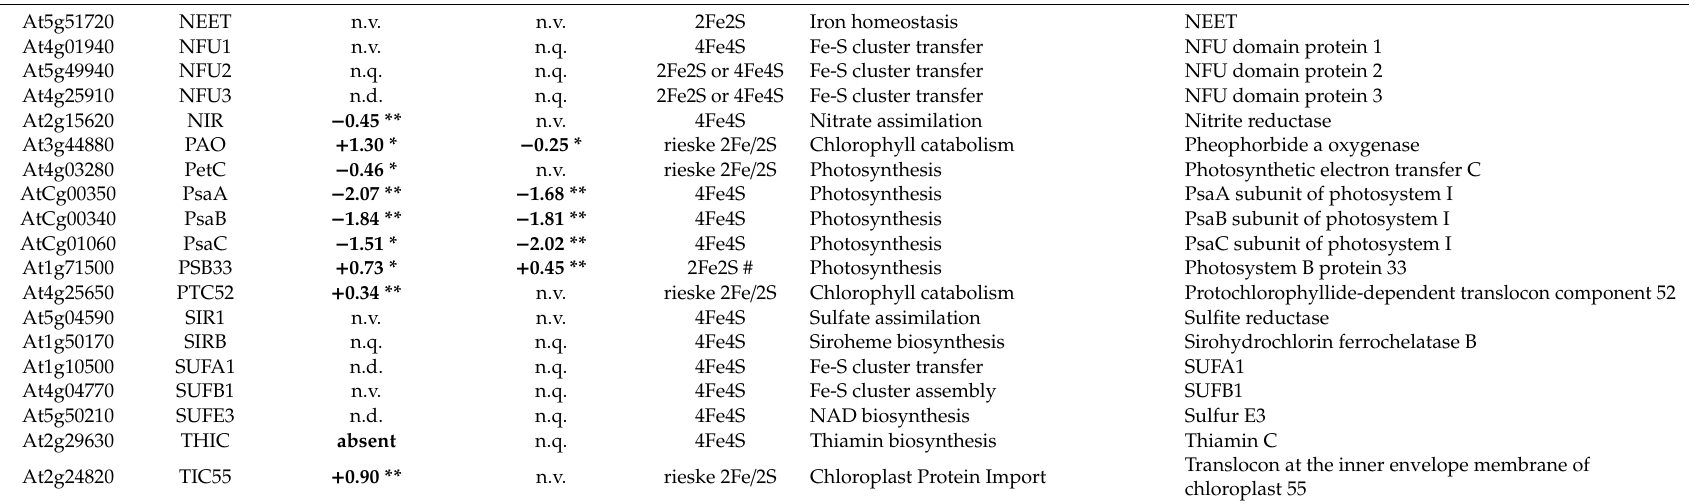
log2 (FC), Logarithmic fold change; absent, detected only in WT samples; n.q., not quantifiable; n.v., no variation; n.d., not detected. Significant differences were assessed by t -test: *: p < 0.05, **: p < 0.01. nfu2-1 data are from